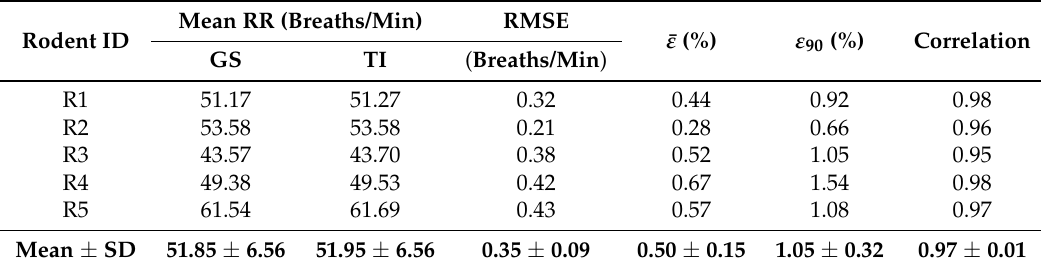
Table 1. Results for RR estimation in thermal videos from rats.